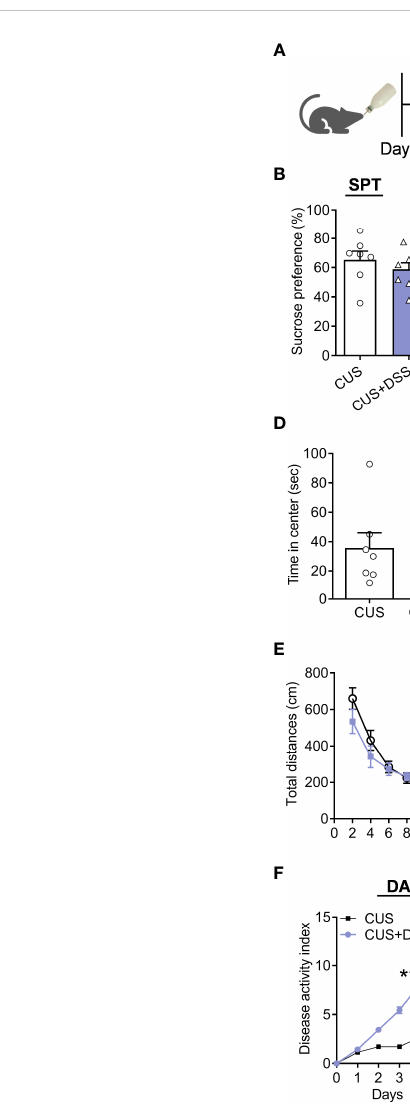
strategy by colonic perfusion of AAV-IL-19-GFP or AAV-GFP (Figure 5A). After a 21-day recovery, the behavioral measurement indicated that there were no changes in preference for 1% sucrose in the AAV-IL-19-GFP group (Figure 5B, t(14)=1.8020, p=0.0932). There was no alteration in the anxiety-related behaviors in the EPM test, with nearly the same TSOA, NEOA, and NEEA (Figure 5C, TSOA: t(14)=0.4201, p=0.6808; NEOA: t(14)=0.0701, p=0.9451; NEEA: t(14)=0.1772, p=0.8619). The LD test showed an increased LIC, decreased TSIC and CIDC in the AAV-IL-19-GFP group (Figure 5D, LIC: Mann Whitney test, p=0.0104; TSIC: t(14) =3.1140, p=0.0076; CIDC: t(14)=2.3570, p=0.0335) comparing to the control group. Furthermore, the AAV-IL-19-GFP group also displayed a decreased TSCZ and TDCZ, and no change in TDT (Figure 5E, TSCZ: t(14)=2.3980, p=0.0310; TDCZ: Mann Whitney